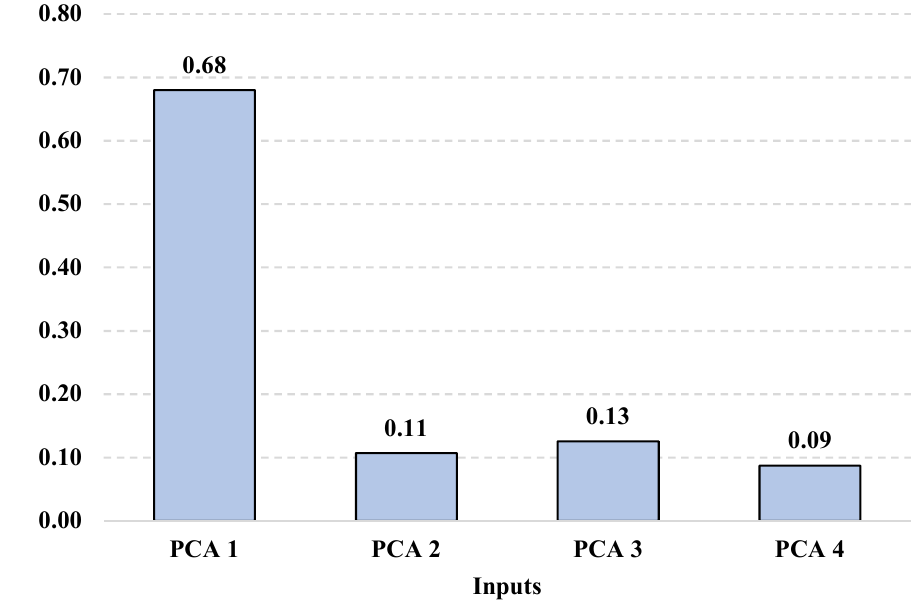
Figure 17. The relative influence of model predictors on the TBM AR.